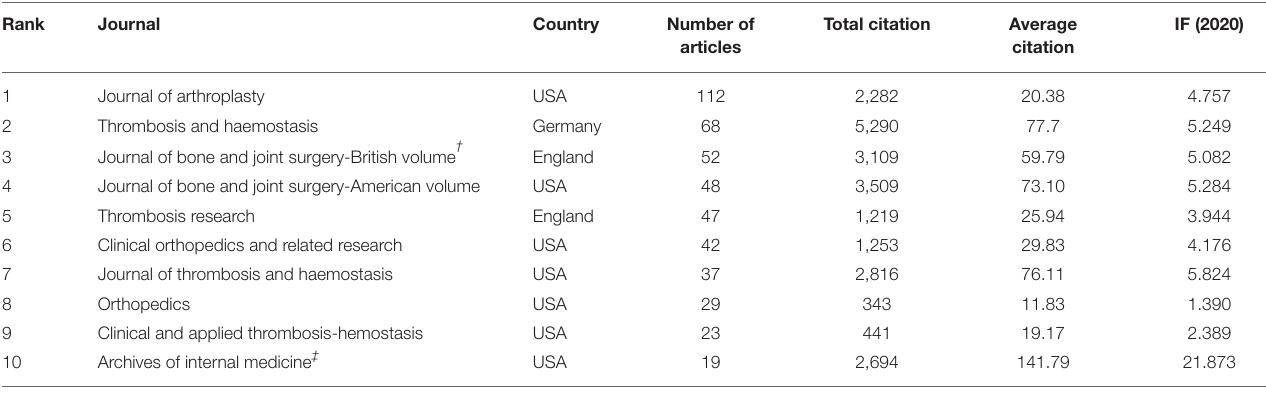
TABLE 4 | List of top 10 journals with the most publications and their impact